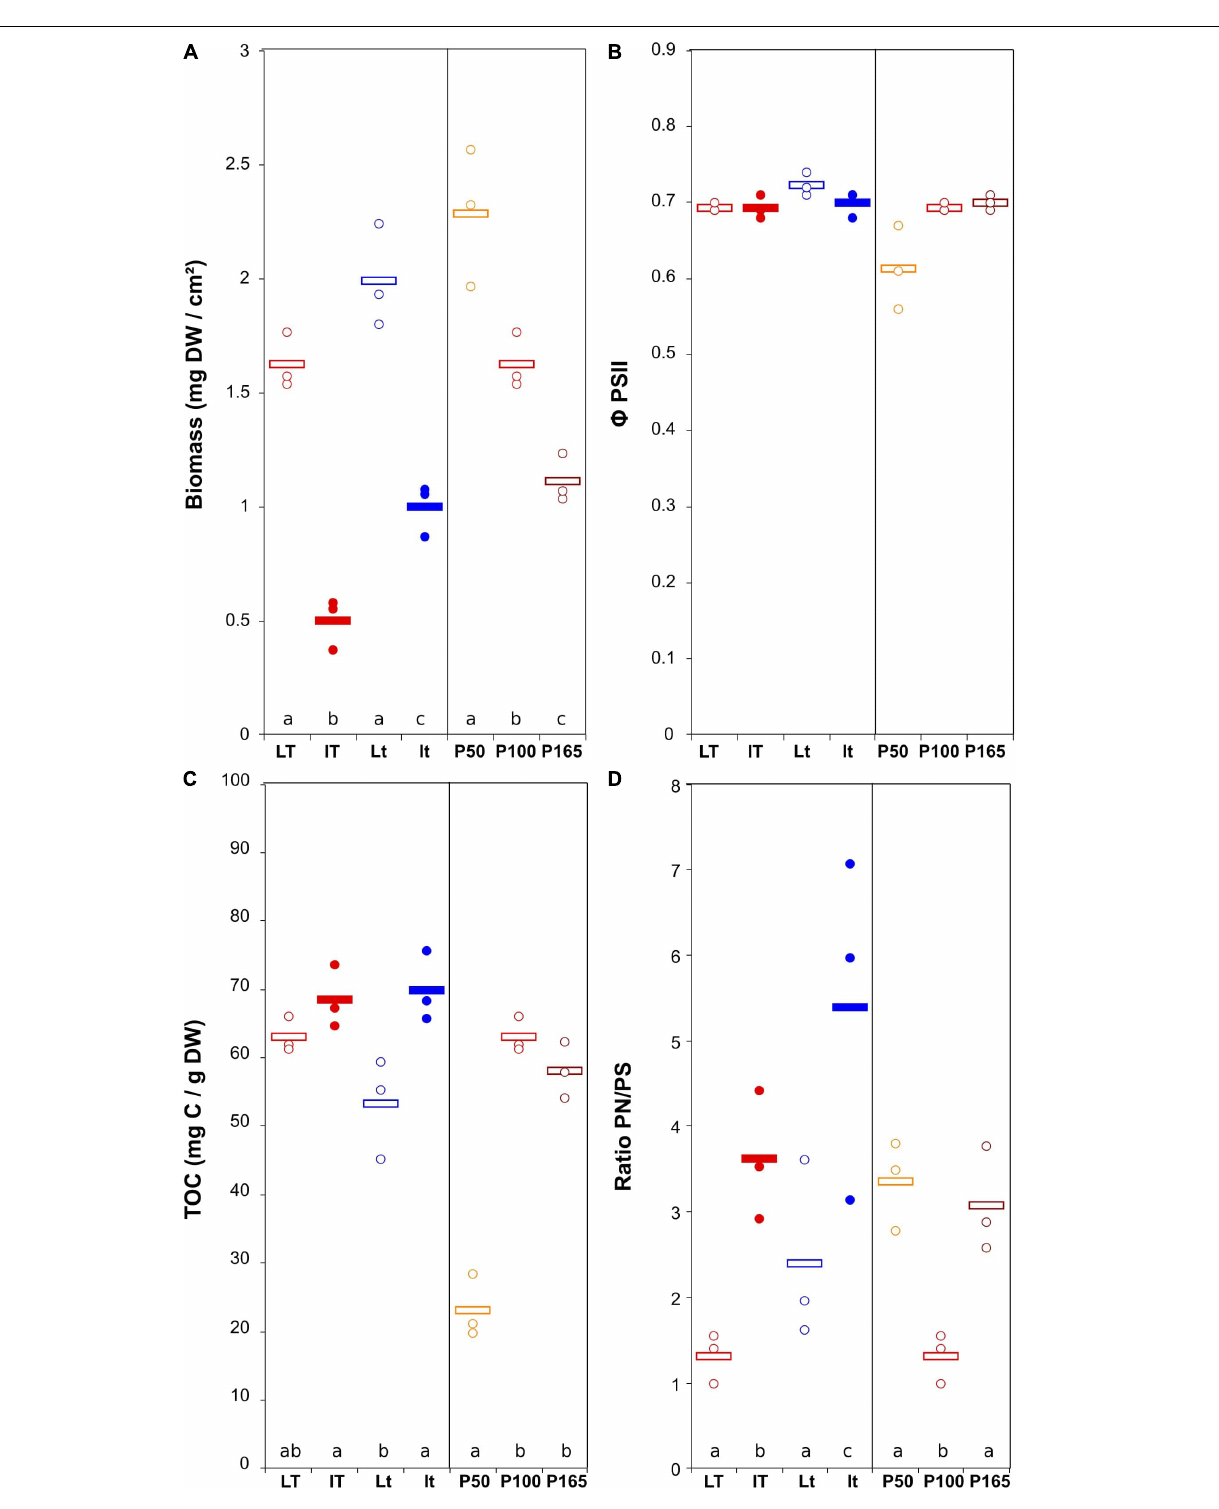
Frontiers in Microbiology |